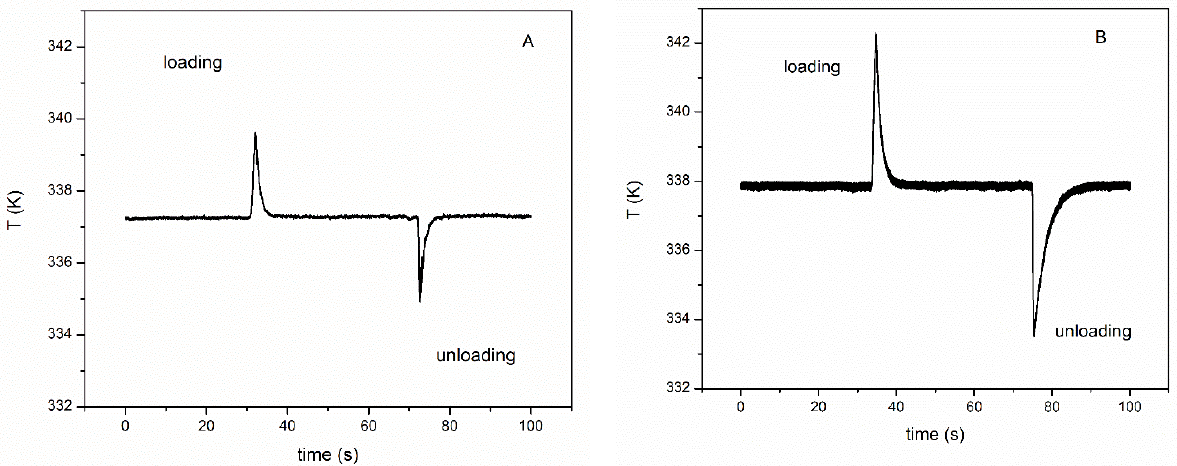
Figure 6. ∆ T range for samples A ( A ) and B ( B ) measured by ad hoc prepared thermocouples Figure 6. Δ T range for samples A ( A ) and ( B ) measured by ad hoc prepared thermocouples system.